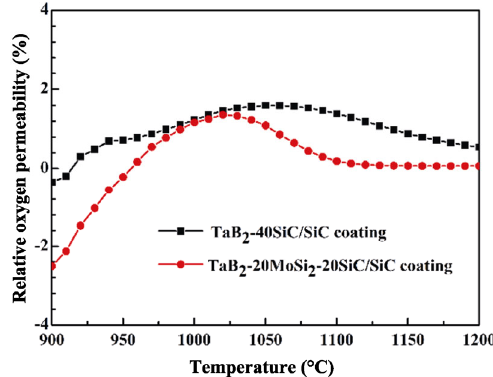
Fig. 8 Relative oxygen permeability curves of the coatings from 900 to 1200 ℃ .